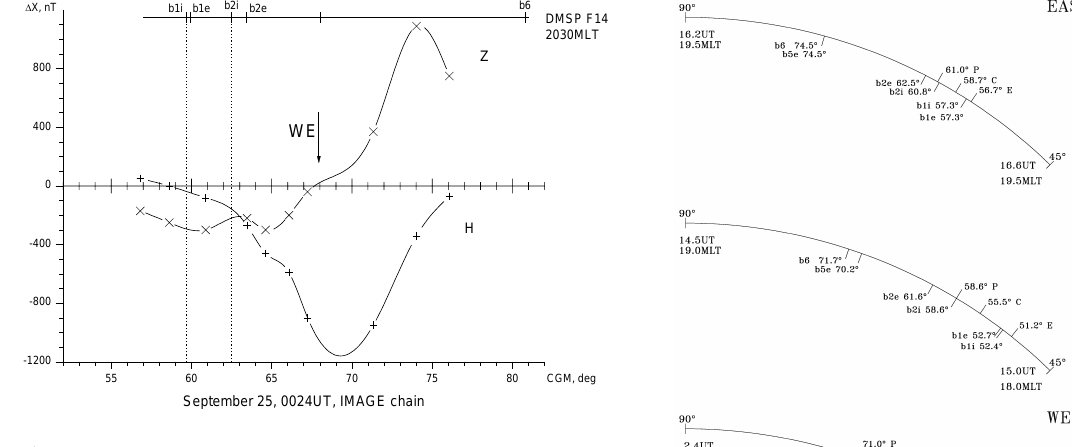
Fig. 8. As Fig. 5, but at 00:24 UT 25 September 1998. Measure- ments from the DMSP F14 pass over auroral latitudes at 20:30 MLT.